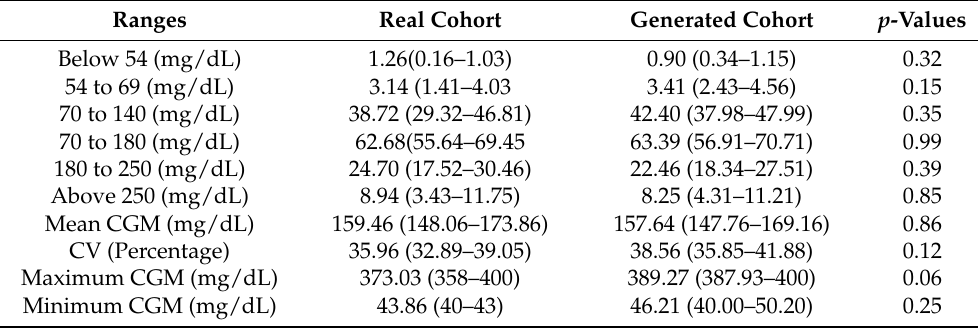
Table 1. A comparison of generated cohort and real cohort: Medtronic’s MiniMed 640G data set (29 patients).